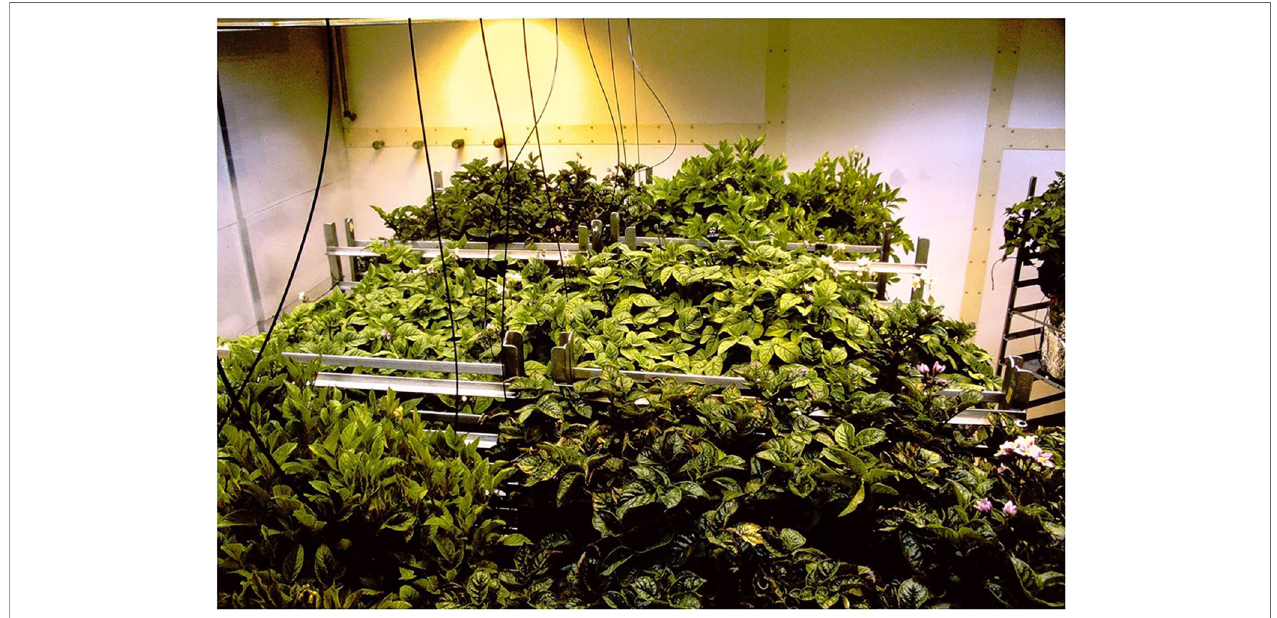
FIGURE 1 | Large walk-in grown chamber at the University of Wisconsin Biotron used for study of potatoes grown at different levels of CO 2 , photosynthetic photon fl ux (PPF), and photoperiods. Three cultivars were included: Russet Burbank, Norland, and Denali. Each cultivar had three plants placed on two mobile carts positioned under 400 µmol m − 2 s − 1 PPF and two under 800 µmol m − 2 s − 1 PPF (total of six plants per treatment). Cart positions were changed at weekly intervals to reduce position